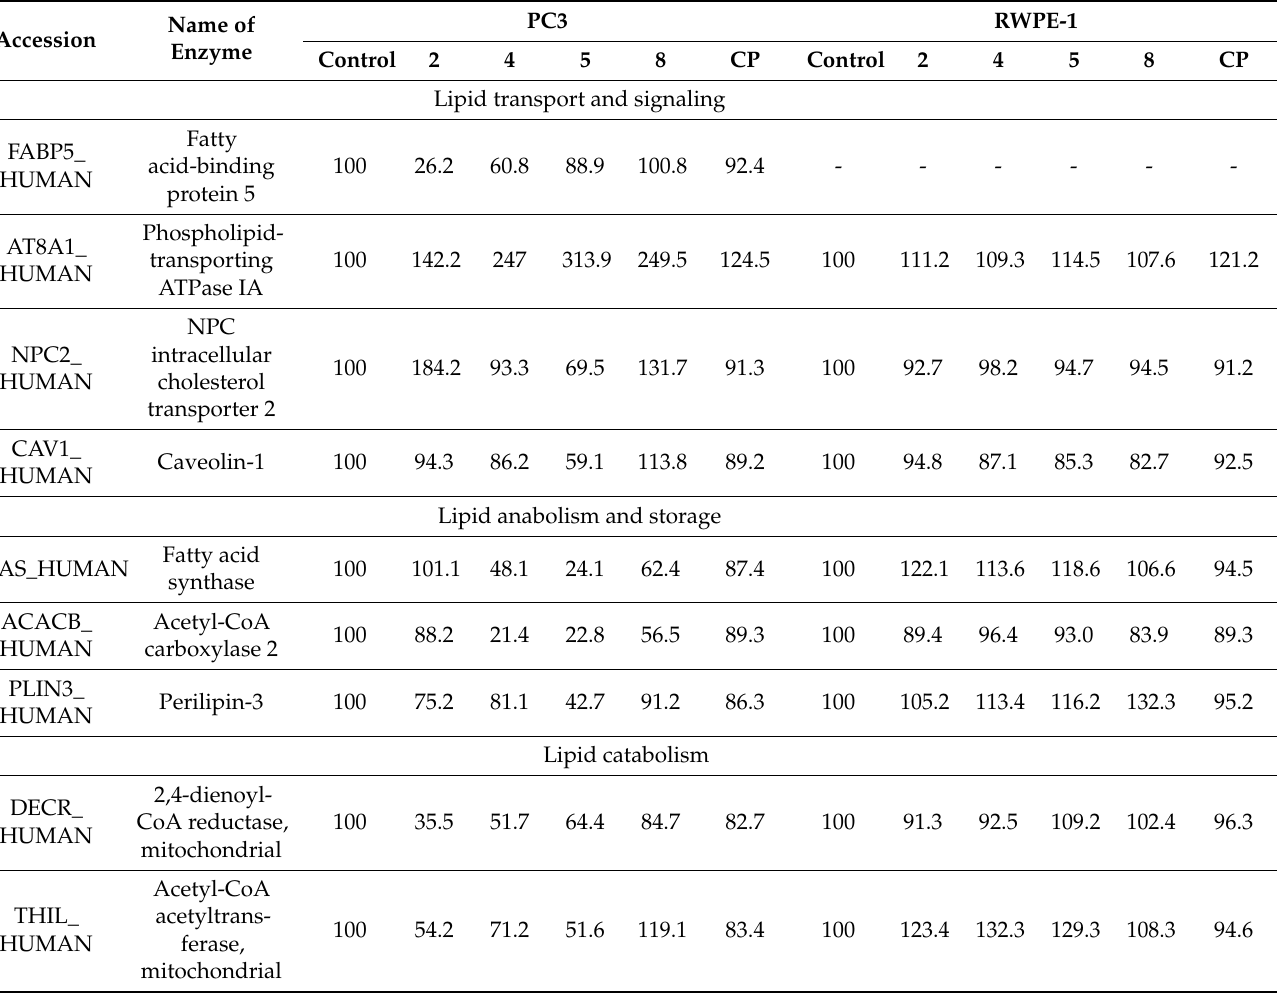
Table 6. LC-MS proteome analysis in PC3 and RWPE-1 cells treated with IC 50 concentrations of conjugates 2, 4, 5 and 8 and free ciprofloxacin. Protein expression was normalized to the control (given as 100%) and shown as a percentage of a